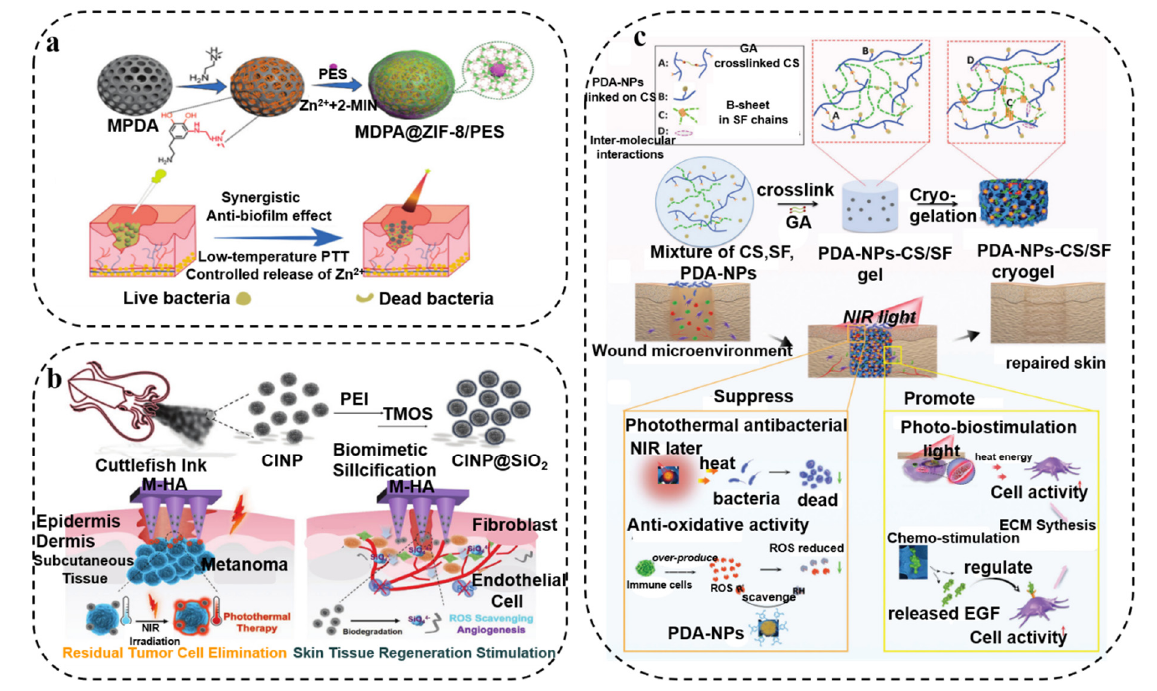
Figure 1. ( a ) Schematic of imidazole framework (ZIF-8)-coated mesoporous polydopamine (MPDA) core–shell nanoparticle-loaded Pifithrin- μ (PES). Reprinted with permission from [50] (copyright: The Royal Society of Chemistry). ( b ) Schematic representation of biomineralized melanin nanoparticles by SiO 2 (CINP@SiO 2 ). Reprinted with permission from [51] (copyright: Wiley-VCH GmbH, 2022). ( c ) Schematics of mussel-inspired PDA-NP-chitosan/silk fibroin (PDA-NPs-CS/SF) cryogels.